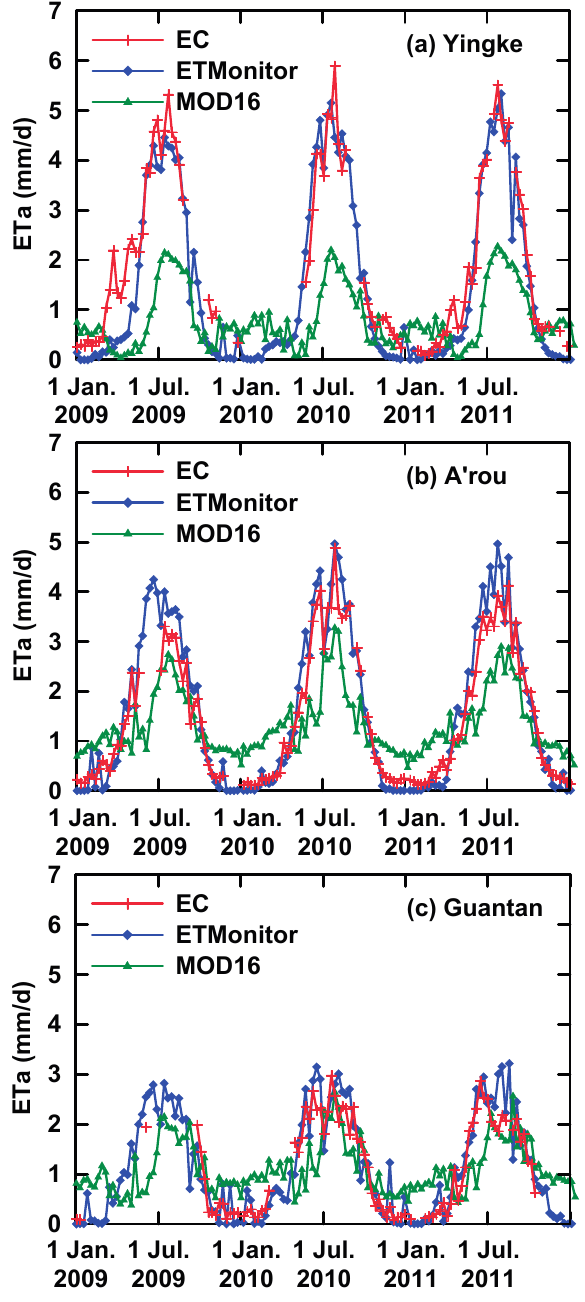
Figure 5. Three-year eight-day time series of ETMonitor, MOD16 and eddy covariance (EC) observed evapotranspiration (ETa) spanning 2009–2011 at the site of ( a ) Yingke (cropland), ( b ) A’rou (alpine meadow), and ( c ) Guantan (forest). Values shown are the eight-day means of ETa